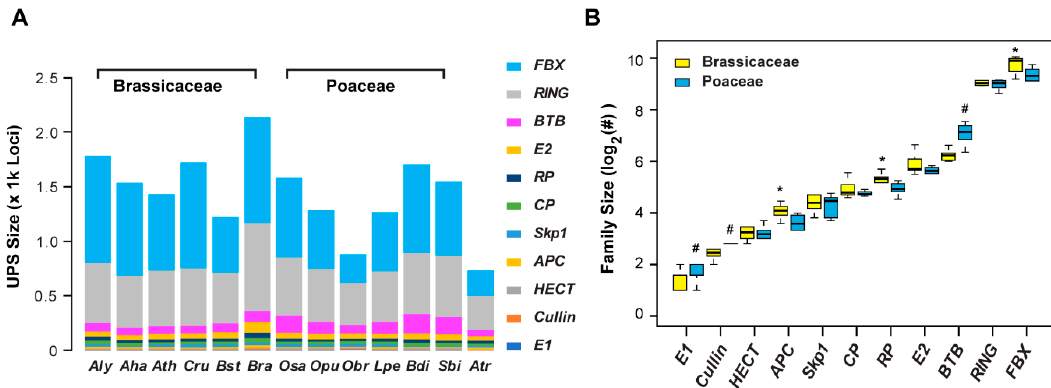
Figure 2. Varied size expansion of the UPS gene families in 13 plant genomes. ( A ) Size comparison of 11 UPS gene families in 13 plant genomes. A schematic diagram of 11 UPS gene families analyzed in this panel and others is described in Figure S1. ( B ) Unequal expansion of 11 UPS gene families in Brassicaceae and Poaceae. Single asterisks indicate that the size of the family is larger in Brassicaceae than that in Poaceae. Hash symbols dedicate a larger family size in Poaceae than in Brassicaceae. Statistical significance was performed based on Wilcoxon rank sum test ( p < 0.05).